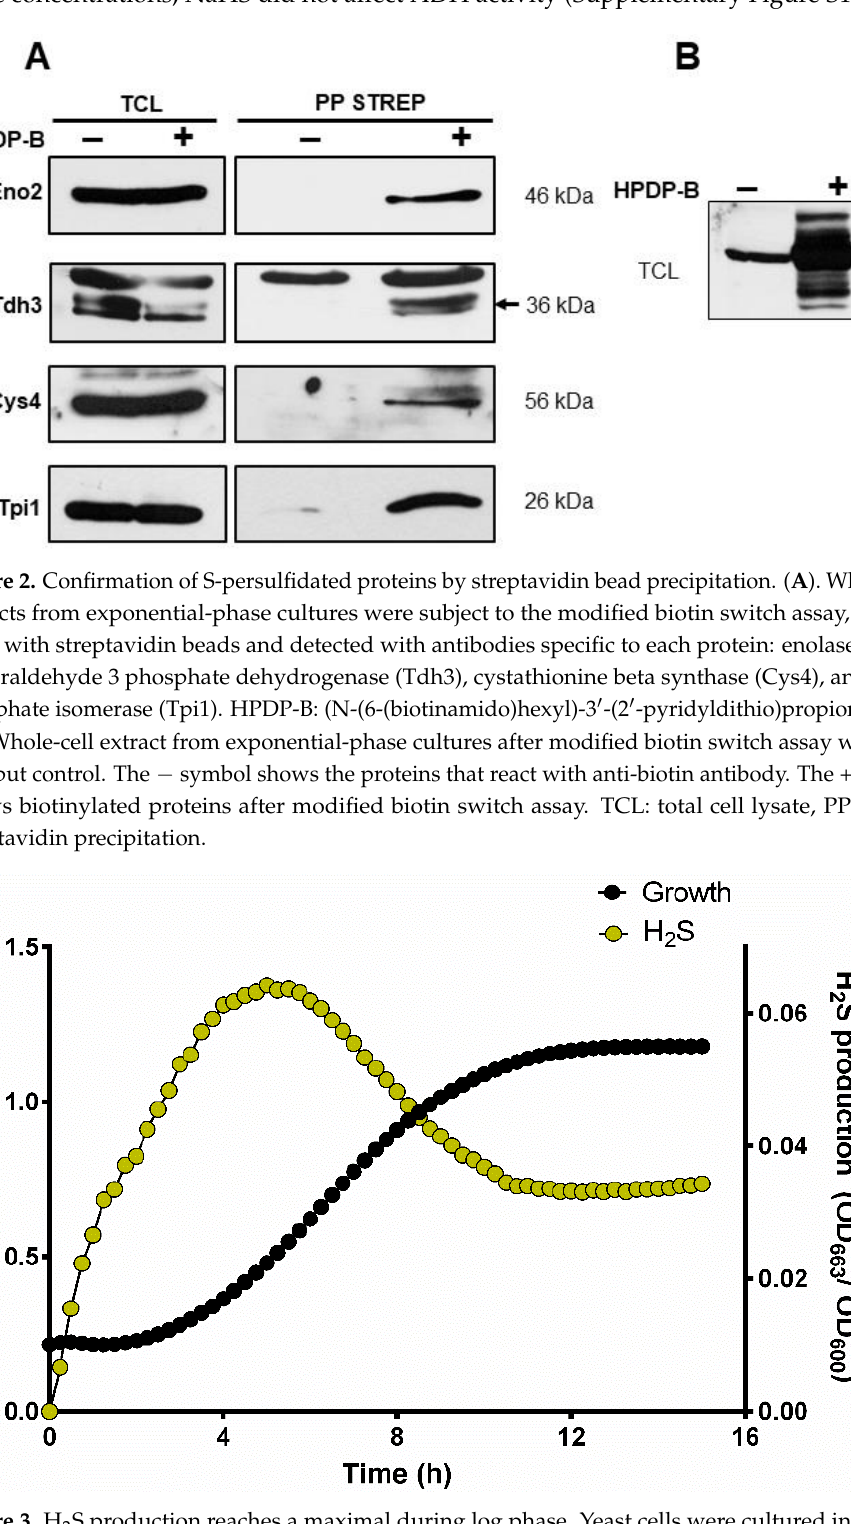
Figure 3. H 2 S production reaches a maximal during log phase. Yeast cells were cultured in 96-well microplates at 30°C, and growth was measured at 600 nm. H 2 S was detected measuring methylene blue reduction at 663 nm.